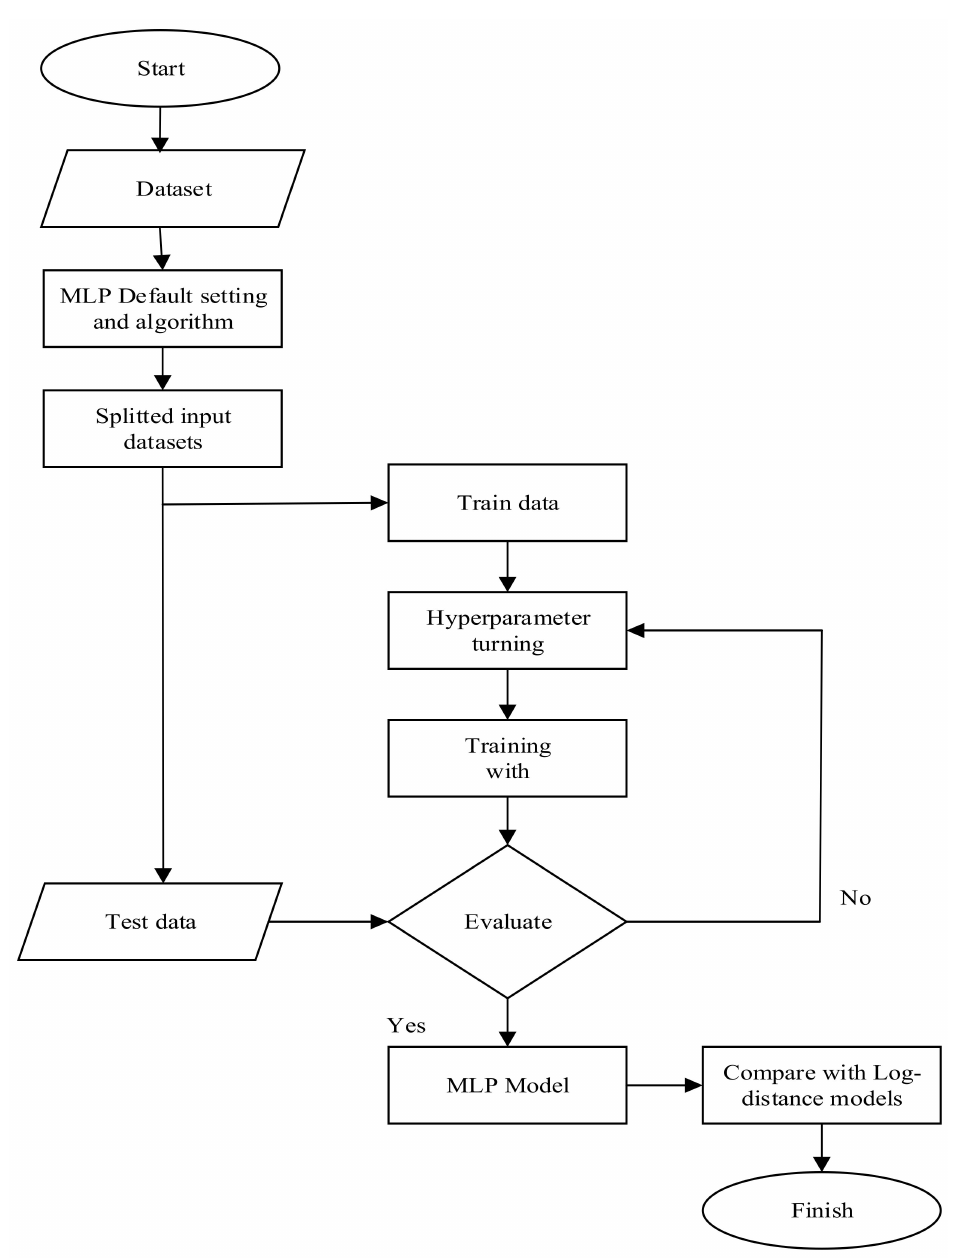
Figure 4. Flowchart for the execution of Proposed Predictive Modelling with MLP Neural